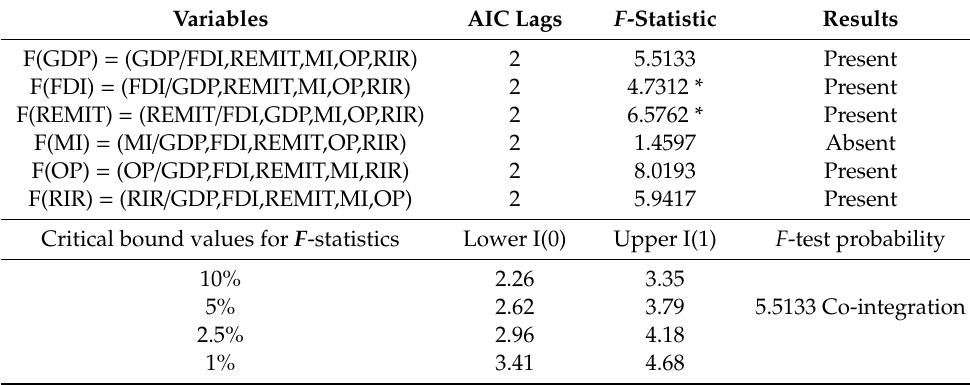
Table 4. Autoregressive distributed lag (ARDL) result of